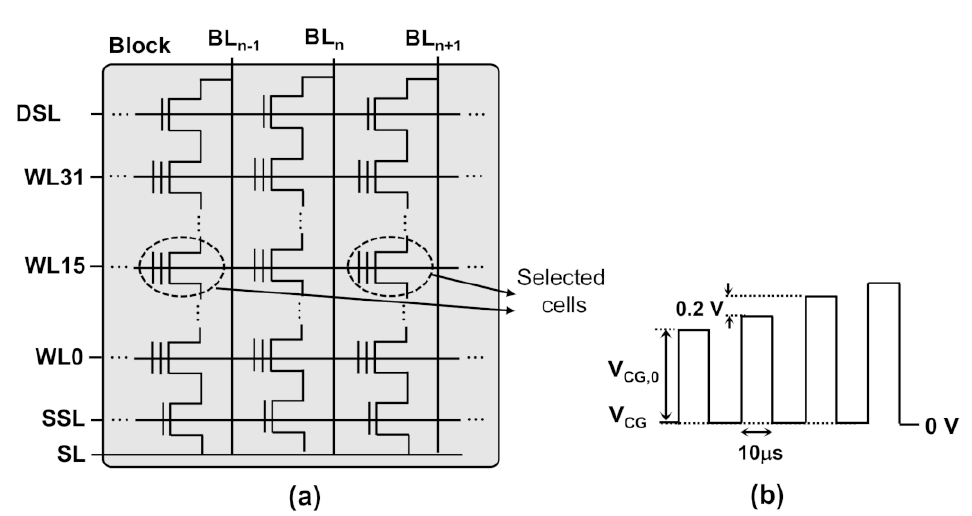
Figure 4. Schematic view of ( a ) NAND Flash array and ( b ) ISPP operation. Adapted from [39].